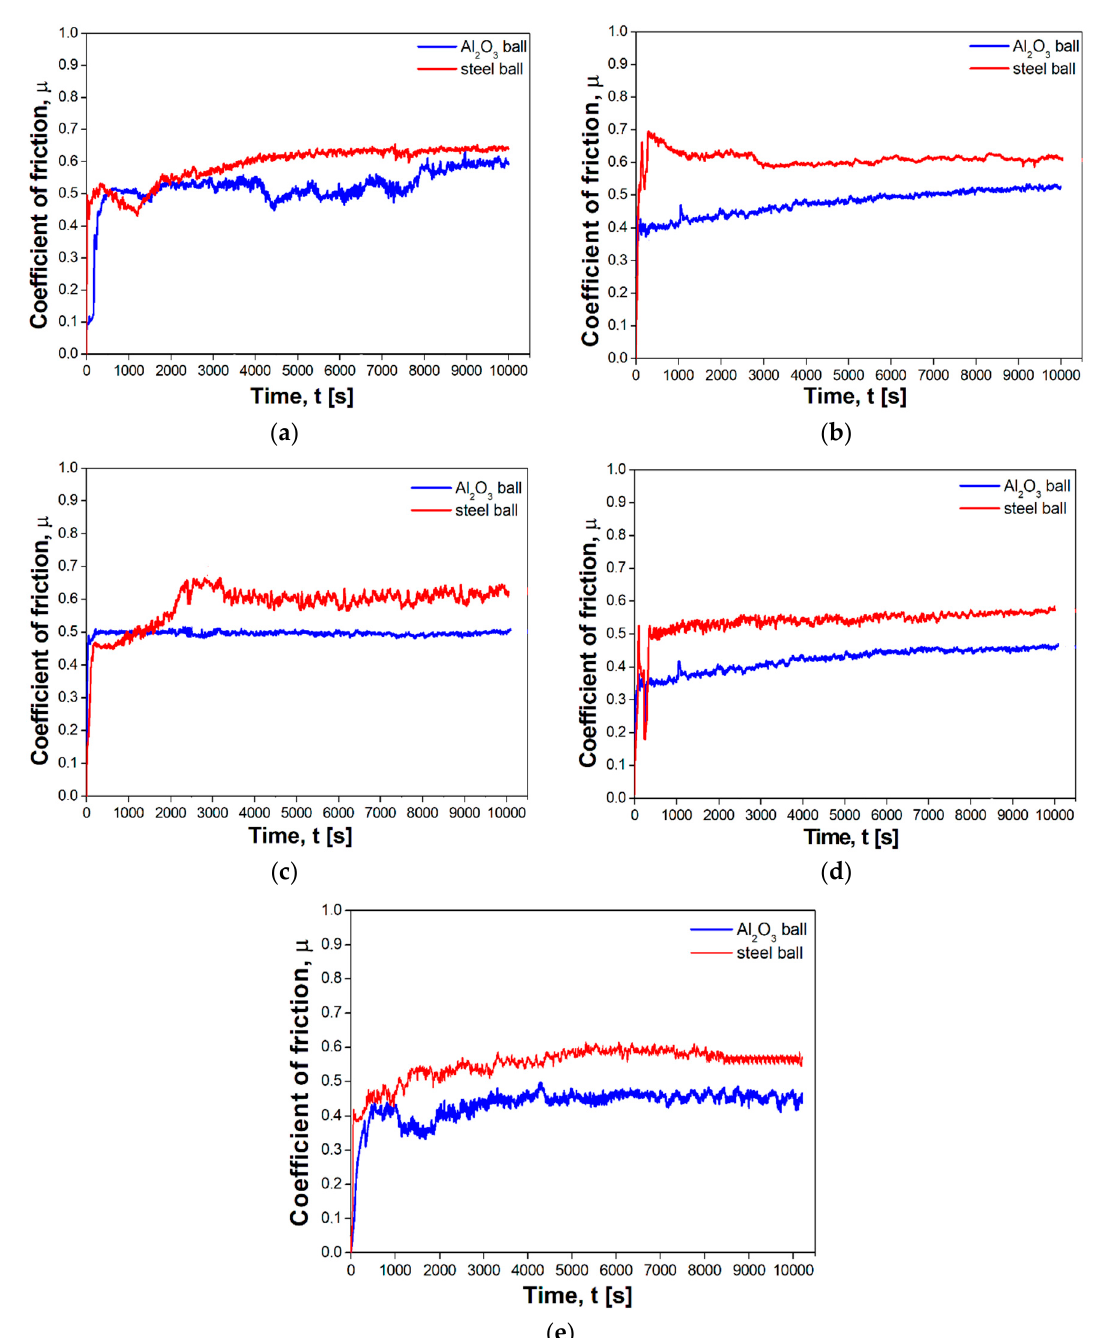
Figure 11. Typical COF curves of ( a ) 316L steel and composites containing: ( b ) 5% ZrB 2 , ( c ) 10% ZrB 2 , ( d ) 15% ZrB 2 and ( e ) 20% ZrB 2 as function of testing time, measured using different balls.